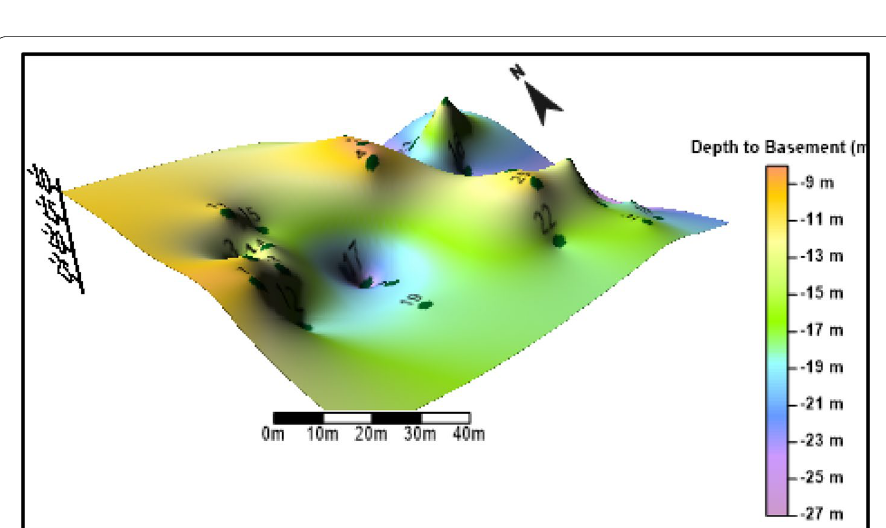
Fig. 13 Map showing basement topograhpy underlying the study